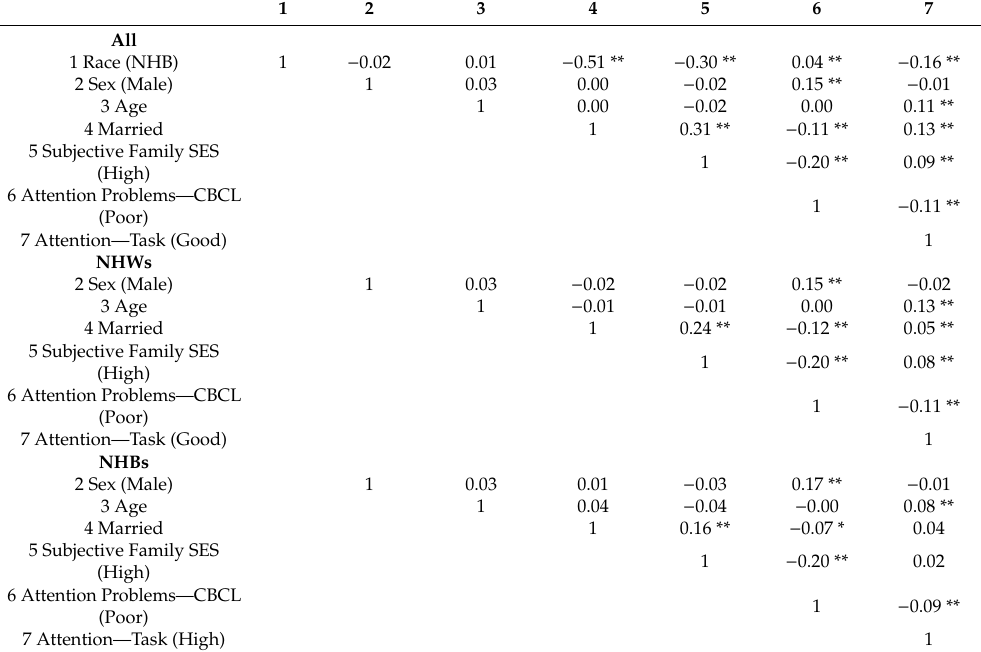
Table 2. Correlations between the study variables ( n = 4188)